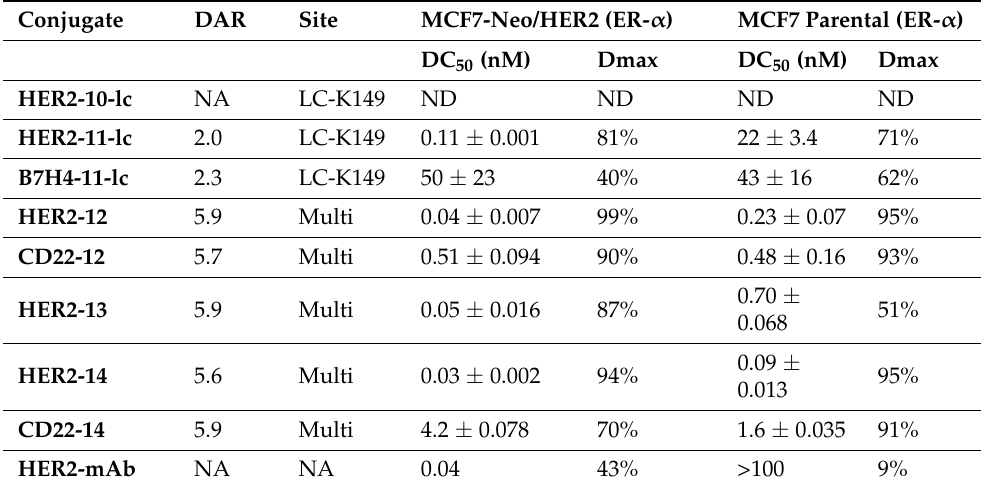
Table 4. Molecular binding characteristics of PROTAC and SNIPER-based Antibody Drug Conjugates. Reproduced with permission from Dragovich et al. [143] Copyright 2020